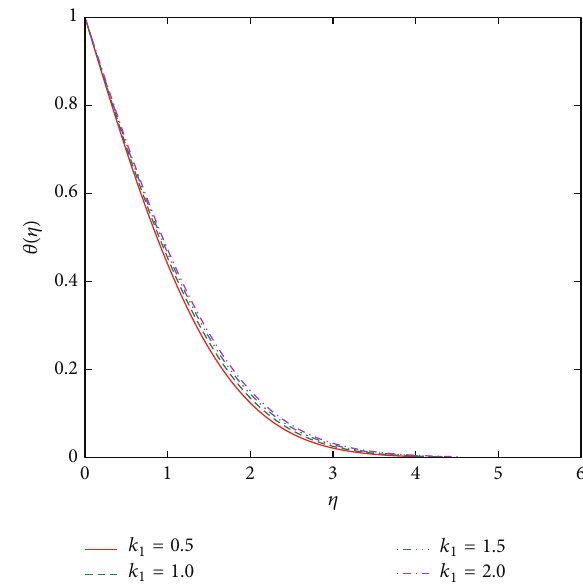
Figure 7: The effect of 𝑘 1 on temperature profile when 𝜆 𝑇 = 0.4 , Pr = 1.0 , and 𝑚 = 0.5